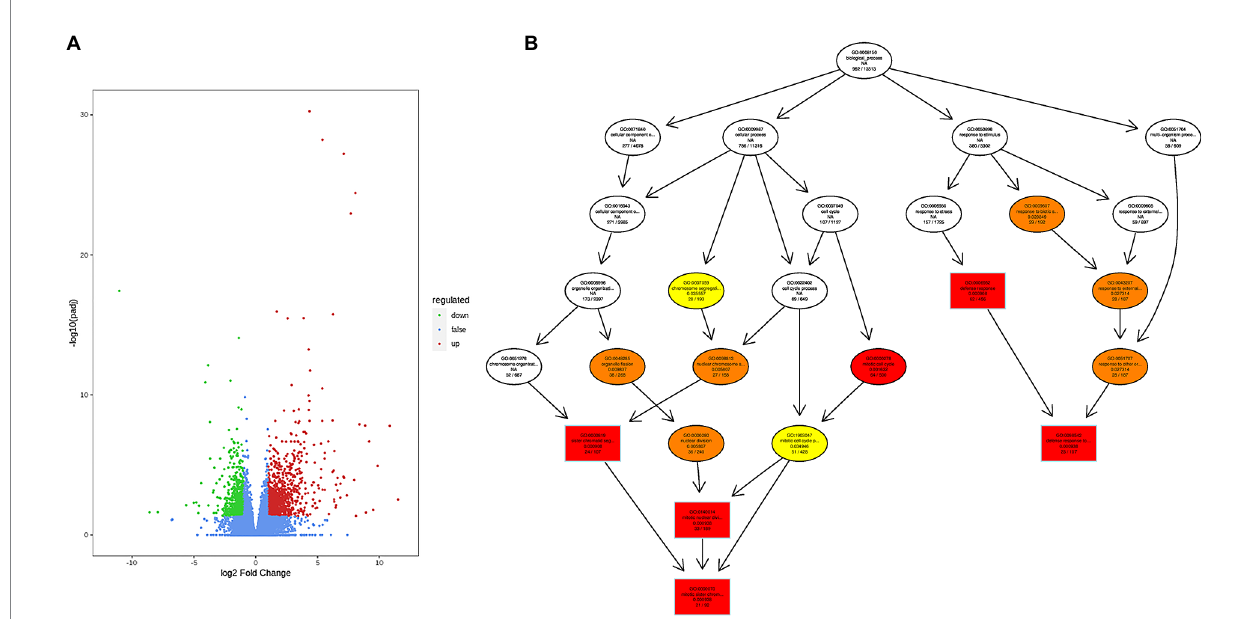
FIGURE 2 DEG analysis after infection with Aeromonas hydrophila . (A) Volcano plot of DEGs. (B) The biological process after infection by GO enrichment